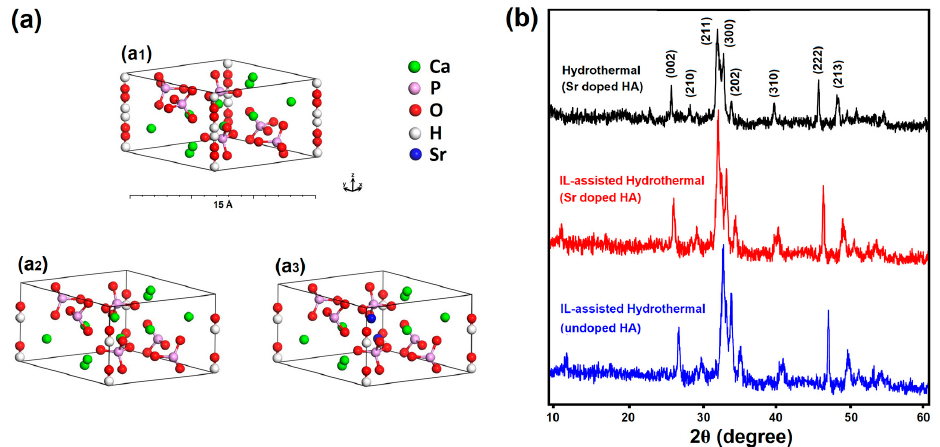
Figure 1. ( a ) Hexagonal primitive cell of HA and Sr-doped HA and ( b ) XRD patterns of the as-synthesized products. Table 1. Experimental and computational calculated unit cell parameters of the as-prepared